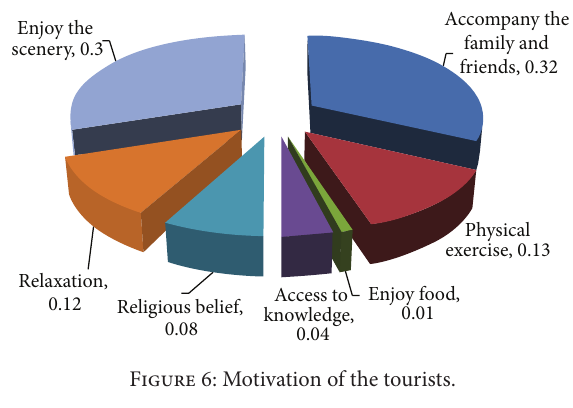
Accompany the family and friends, 0.32